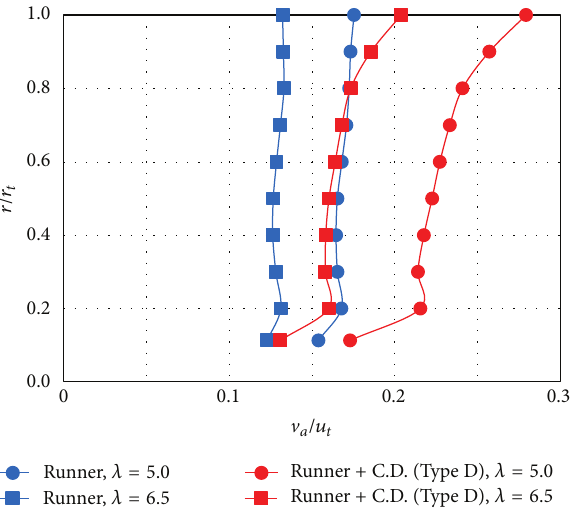
Figure 15: Radial distributions of the axial component of the absolute velocity at the runner inlet.